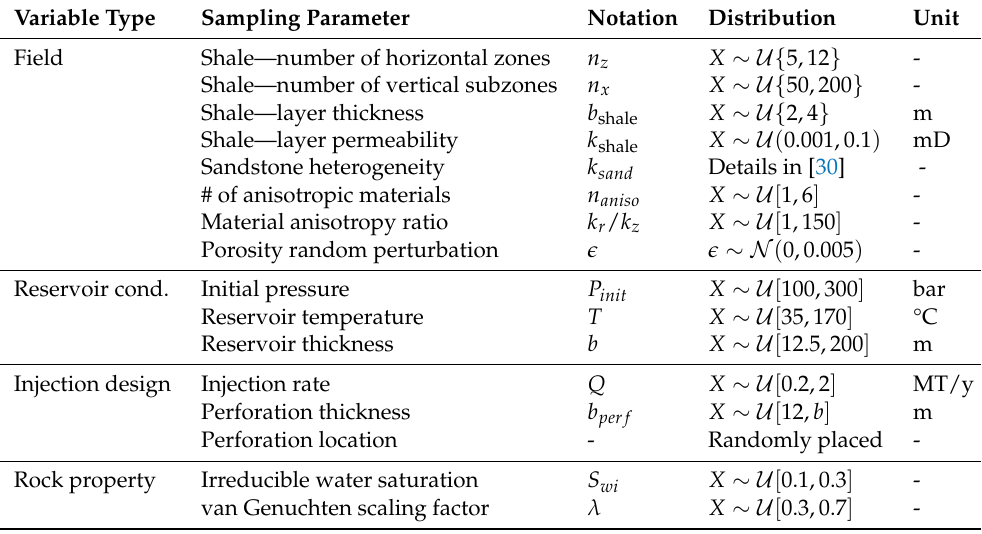
Table 1. Variables, parameters, and sample ranges used for generating the input dataset. The reservoir conditions, injection design, and rock property variables are designed based on